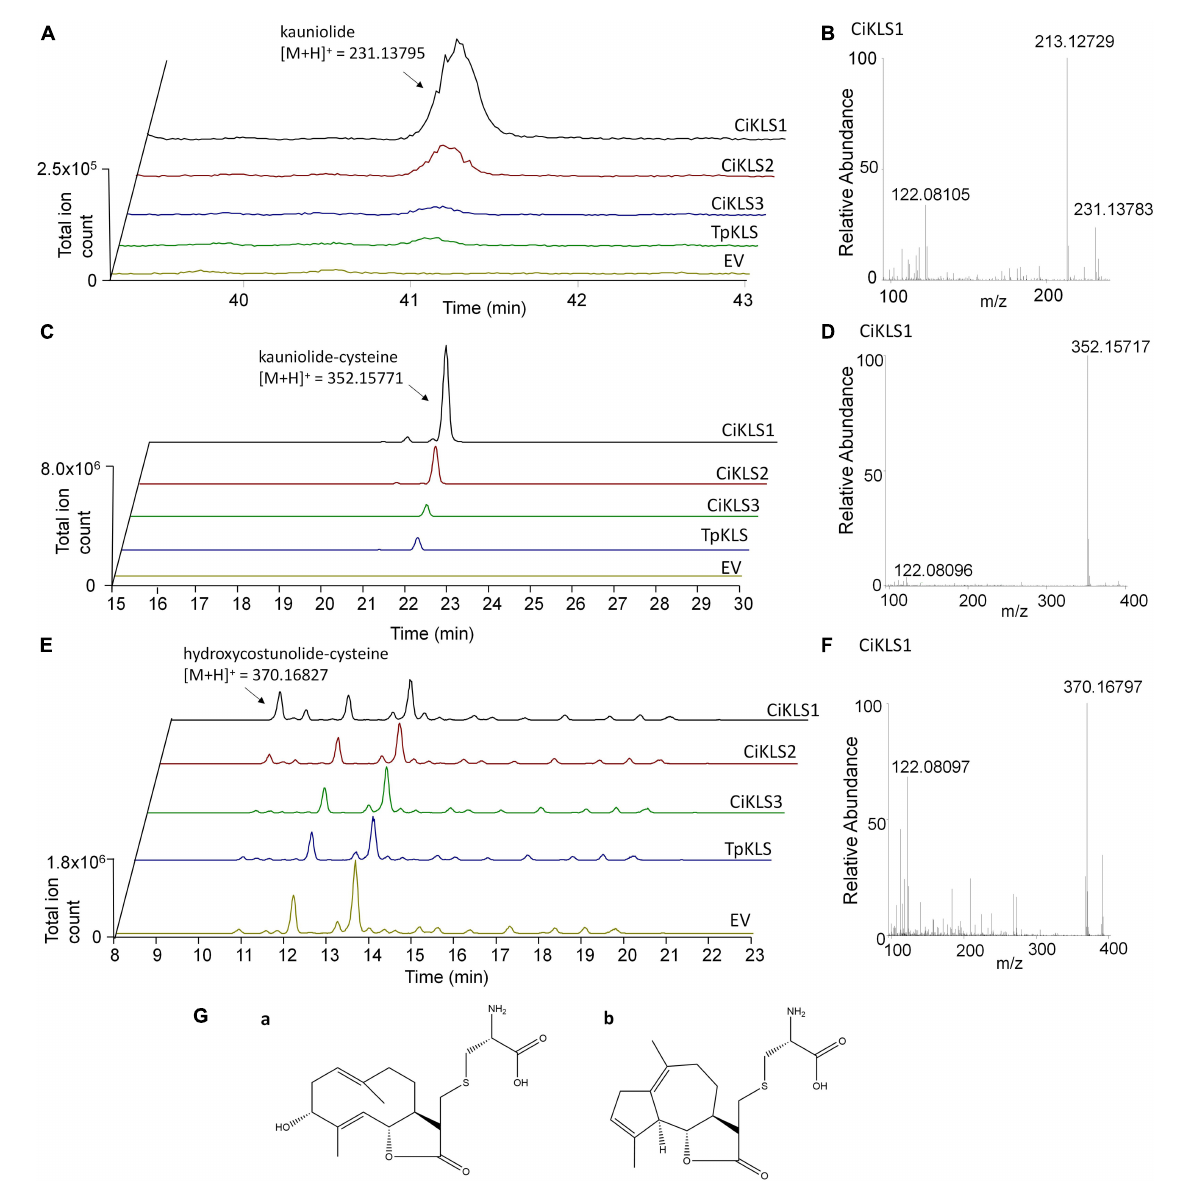
chicory protoplasts. After 1 day 42 ± 1% of the